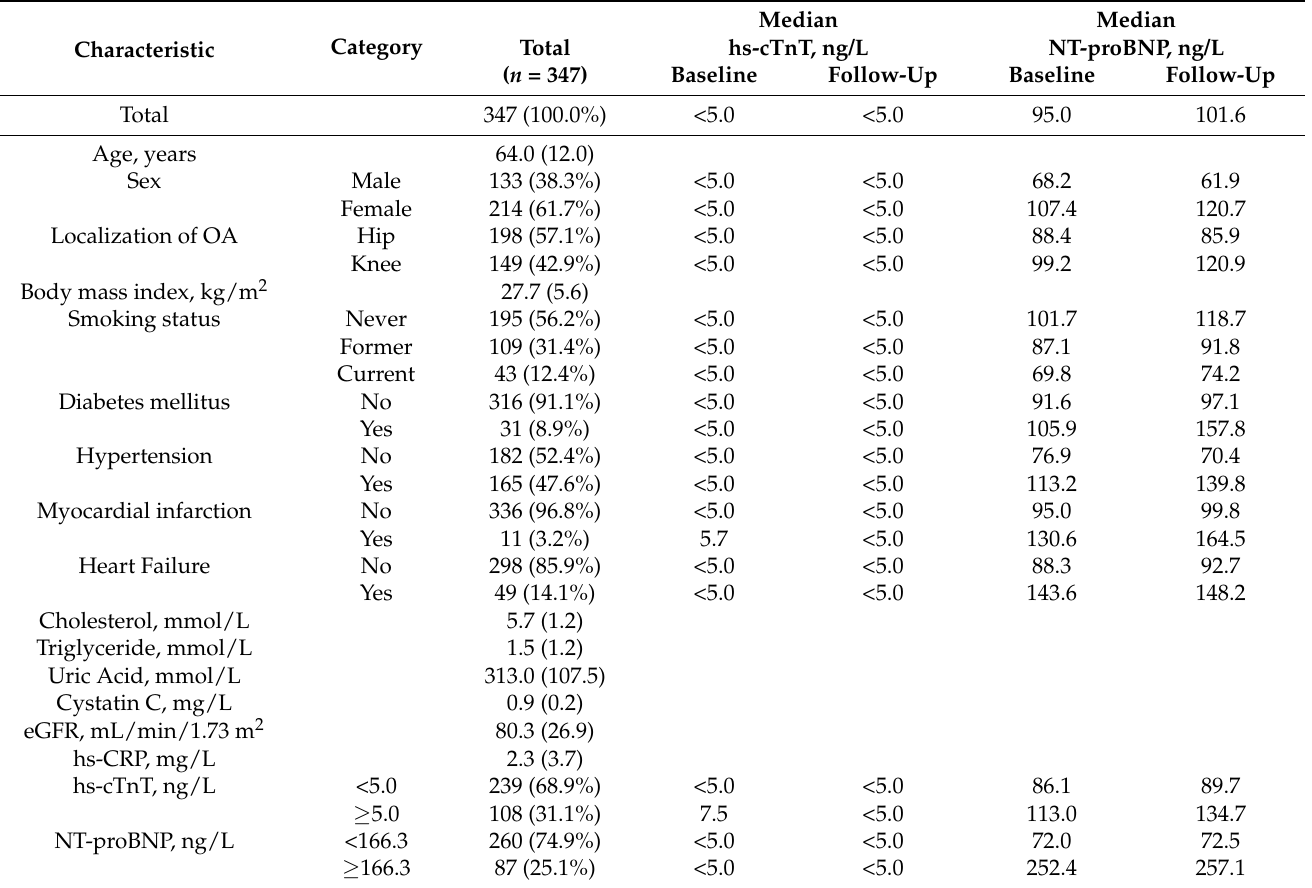
Table 1. Baseline characteristics and median cardiac biomarker concentrations at baseline and one-year follow-up.